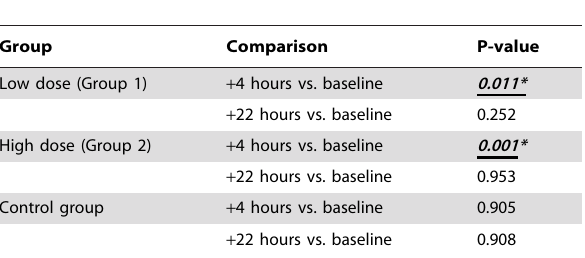
Table 2. Lanthony Panel D-15 test of color vision.